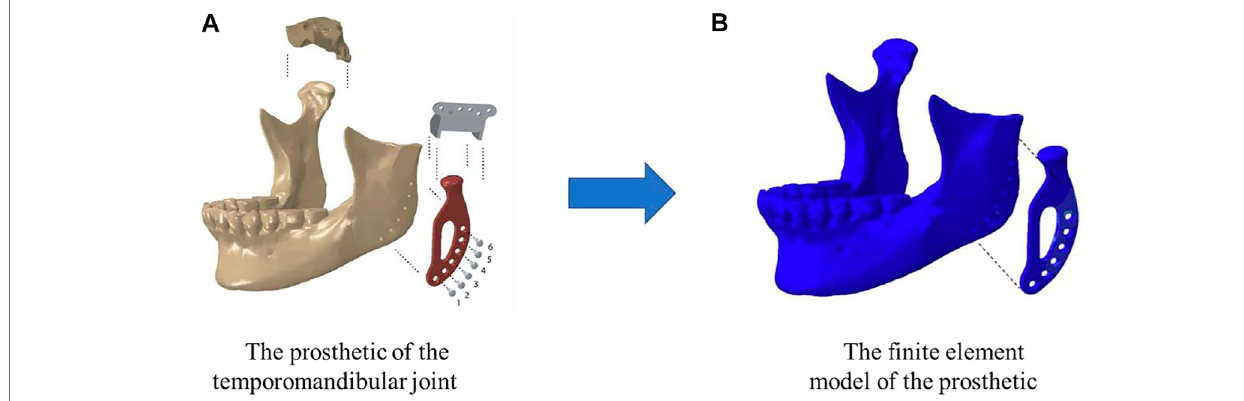
FIGURE 4 | A temporomandibular joint produced by 3D print (adapted from Ackland et al., 2017).